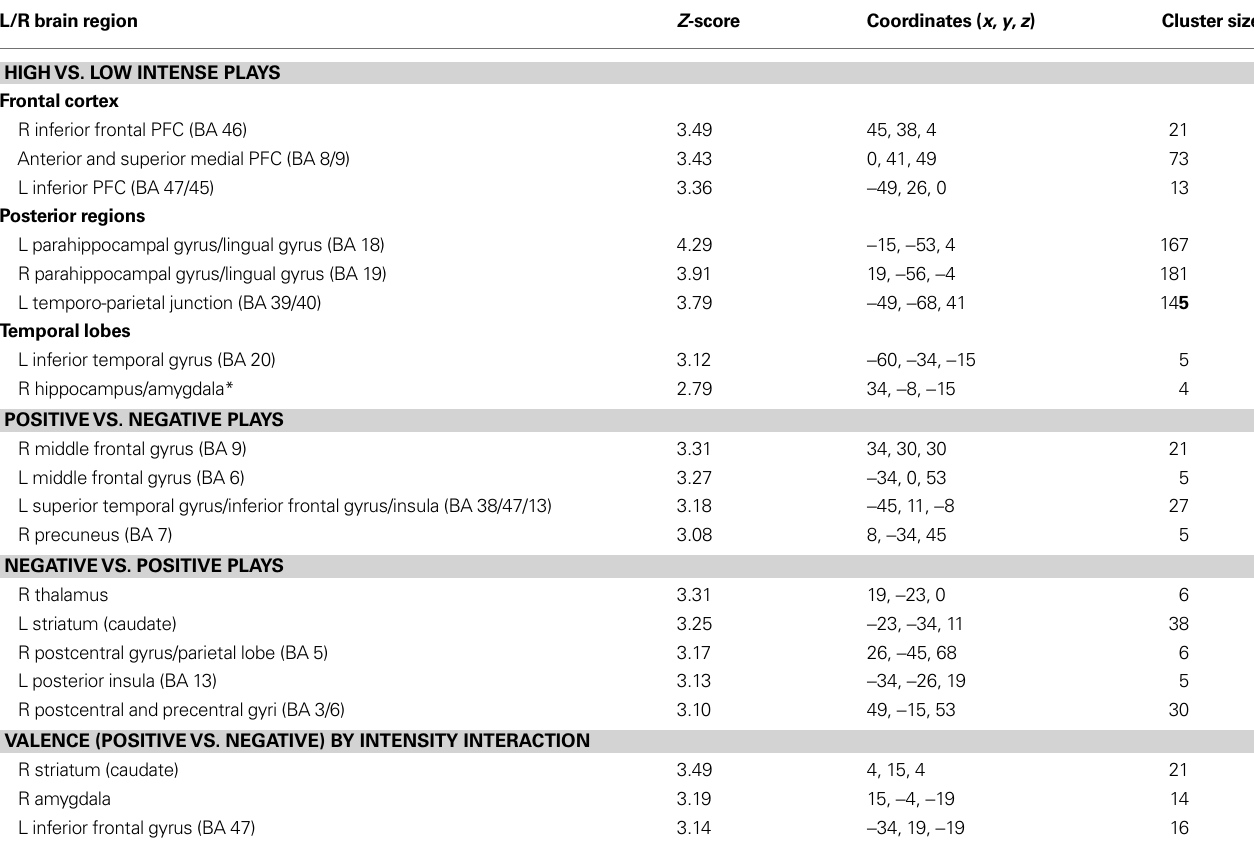
Table 3 | Results from the general linear model analysis. L/R brain region Z -score Coordinates ( x , y , z ) Cluster